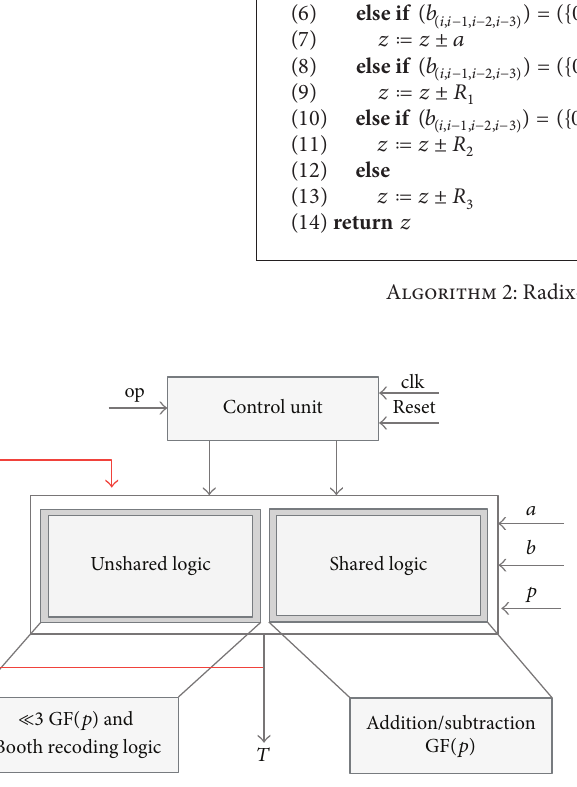
Figure 1: Unified Add/Sub/Mul unit.